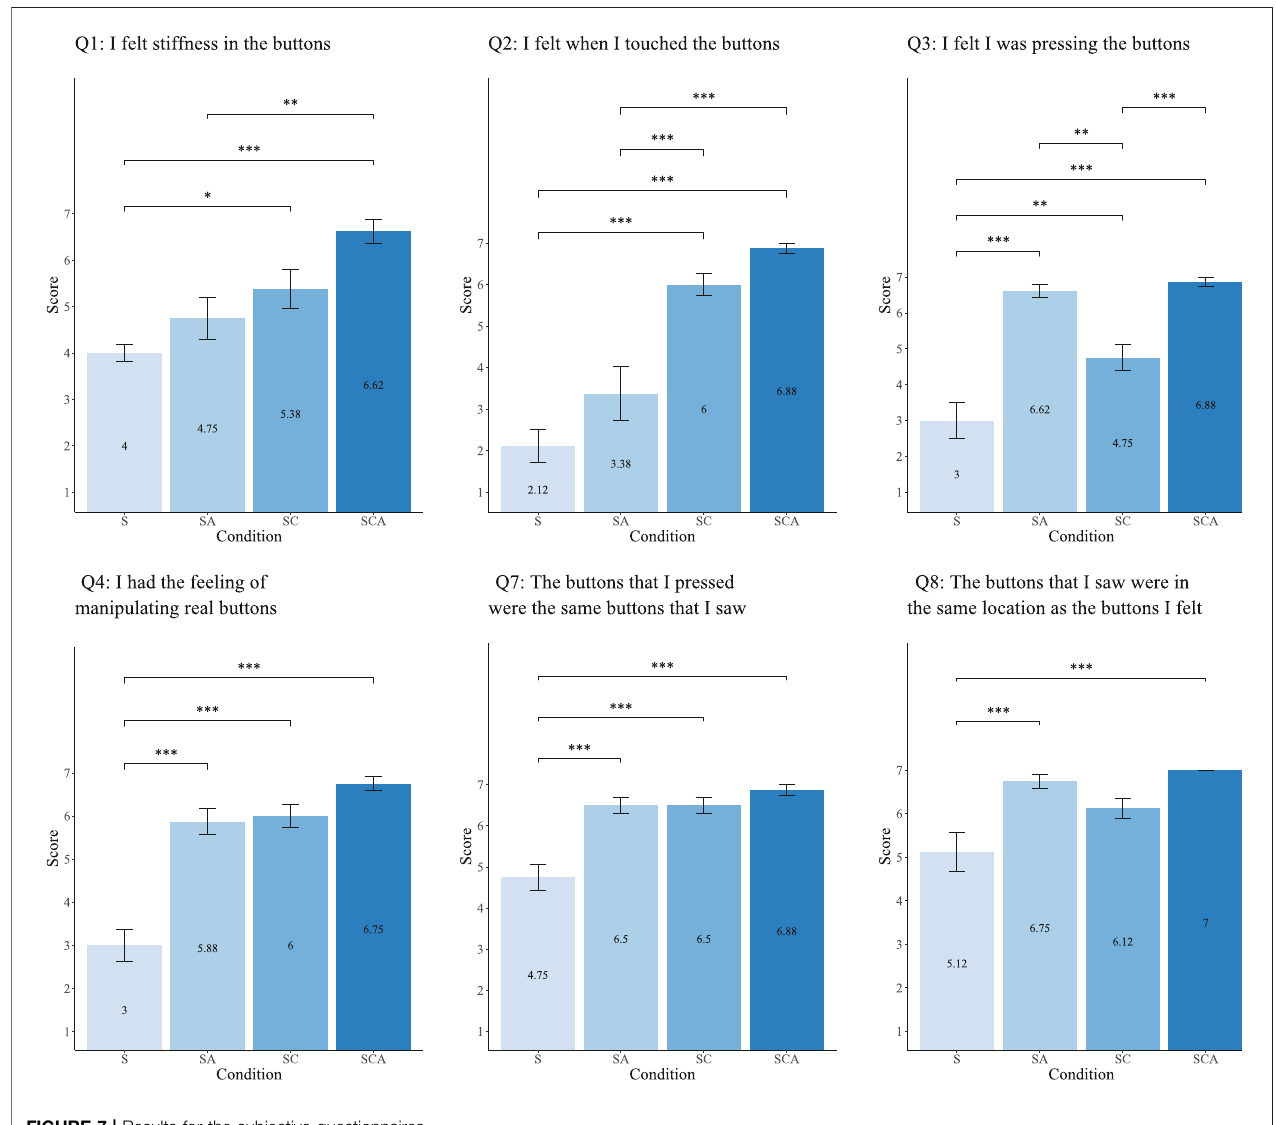
FIGURE 7 | Results for the subjective